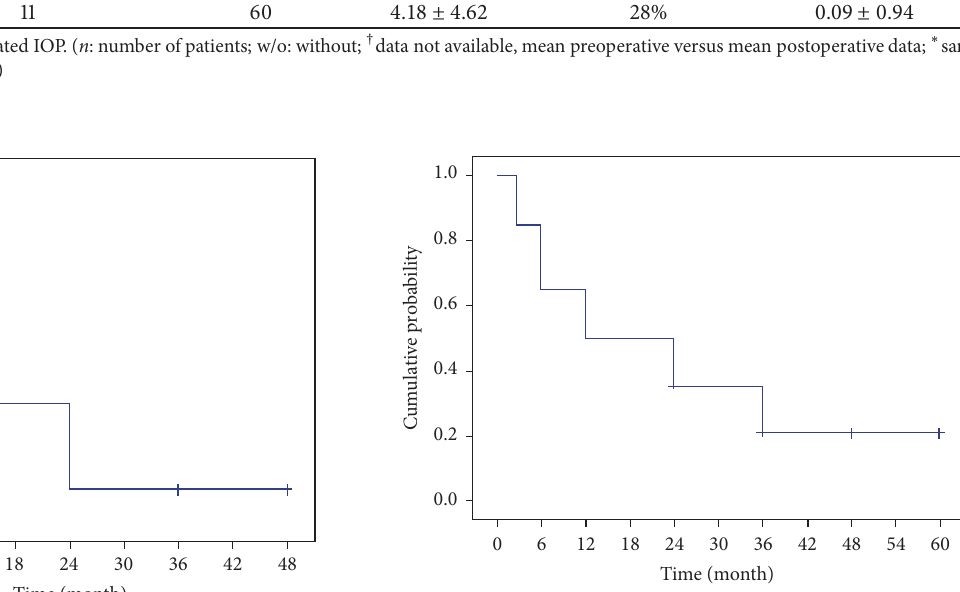
Figure 5: Kaplan-Meier plot of the cumulative probability of com- plete success, defined as an IOP ≤ 18 mmHg without postoperative medication.